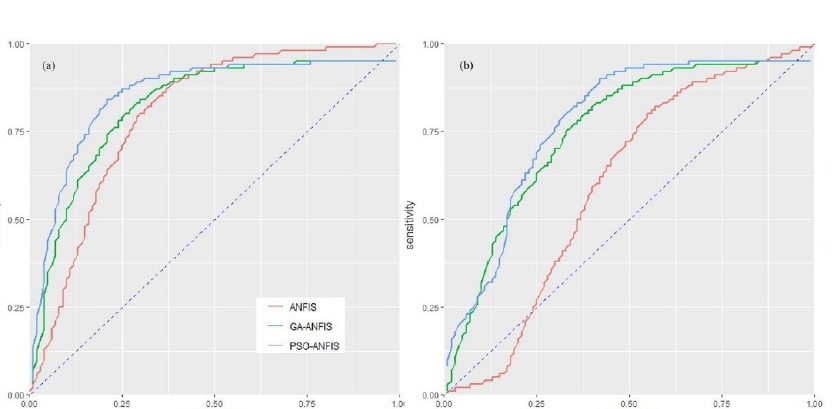
Figure 4. ROC curves for the model of ANFIS, PSO ‐ ANFIS, and GA ‐ ANFIS, produced by sensibility and specificity. ( a ) Training dataset represents success rate of the model, ( b ) testing dataset repre ‐ sents prediction rate of the model.